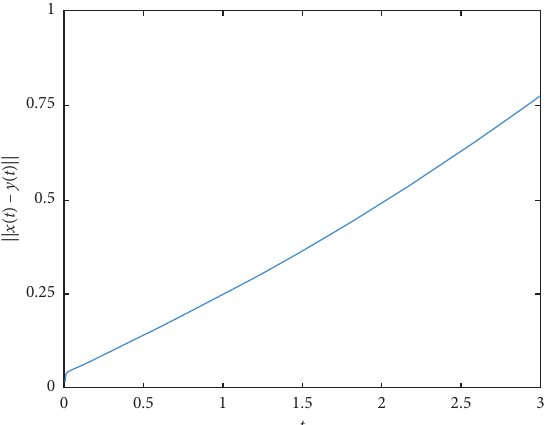
Figure 2: The time response for the error between x ( t ) and y ( t )